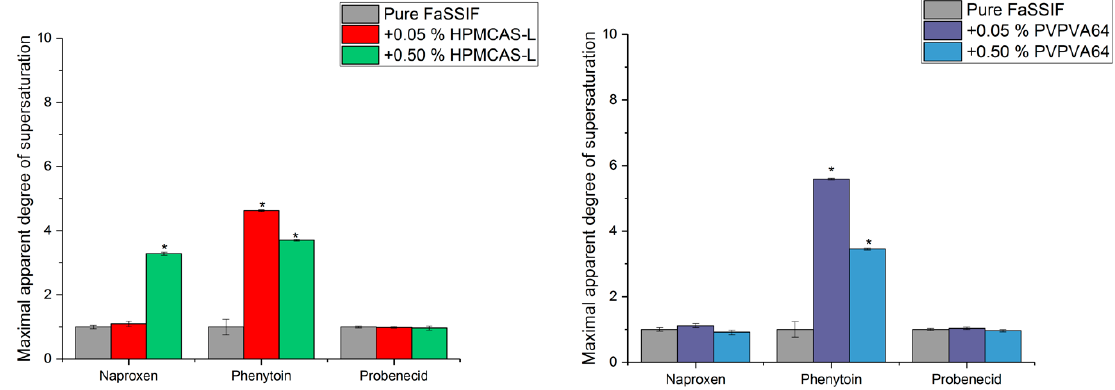
Figure 2. Maximum apparent degree of supersaturation of naproxen, phenytoin and probenecid in fasted state simulated intestinal fluid (FaSSIF) and in FaSSIF in the presence of hypromellose acetate succinate L-grade (HPMCAS-L) ( left ) or vinylpyrrolidine-vinyl acetate copolymer (PVPVA64) ( right ) using the solvent shift method standardized supersaturation and precipitation method (SSPM) [23].